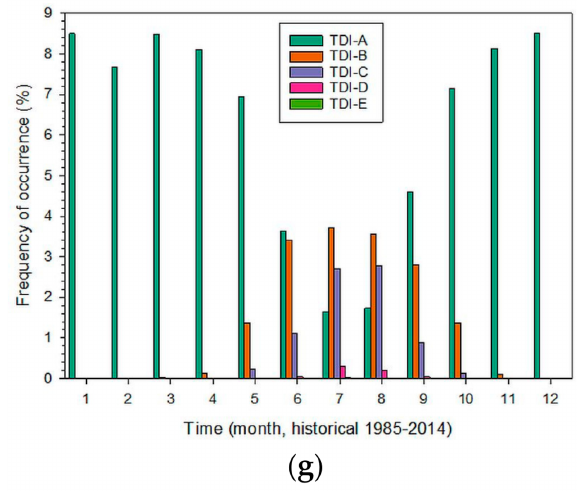
Figure 8. Frequency of occurrence (in %) for the various TDI classes (see Table 1 for definition) across all epochs: ( a ) RCP 4.5 2021–2050, ( b ) RCP 4.5 2046–2075, ( c ) RCP 4.5 2071–2100, ( d ) RCP 8.5 2021–2050, ( e ) RCP 8.5 2046–2075, ( f ) RCP 8.5 2071–2100, and ( g ) historical 1985–2014. The frequencies are averages over all 33 sites in Greece.